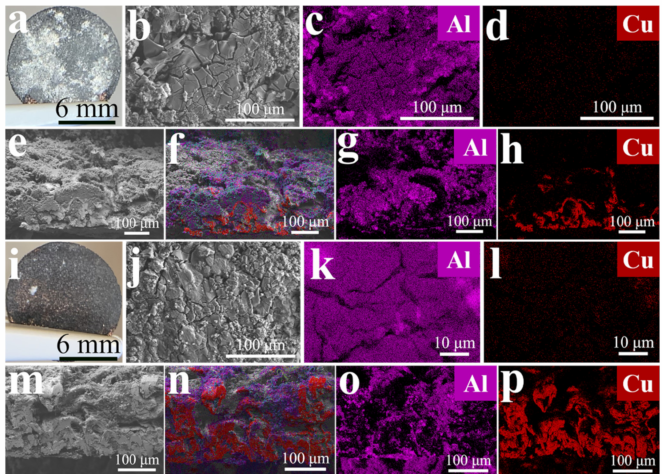
Figure 5. ( a – d , i – l ) The surface and cross-sectional ( e – h , m – p ) morphology stability of the Al/ 3D Cu electrode electrodeposited at –1.85 V and 90 ◦ C firstly discharged ( a – h ) at 4.2 mA g − 1 and charged ( i – p ) at 21 mA g − 1 . ( a , i ) Photograph ( b , e , j , m ) SEM images and ( f , n ) EDX mappings of all elements of ( c , d , g , h , k , l , o , p ) the Al and Cu distribution of